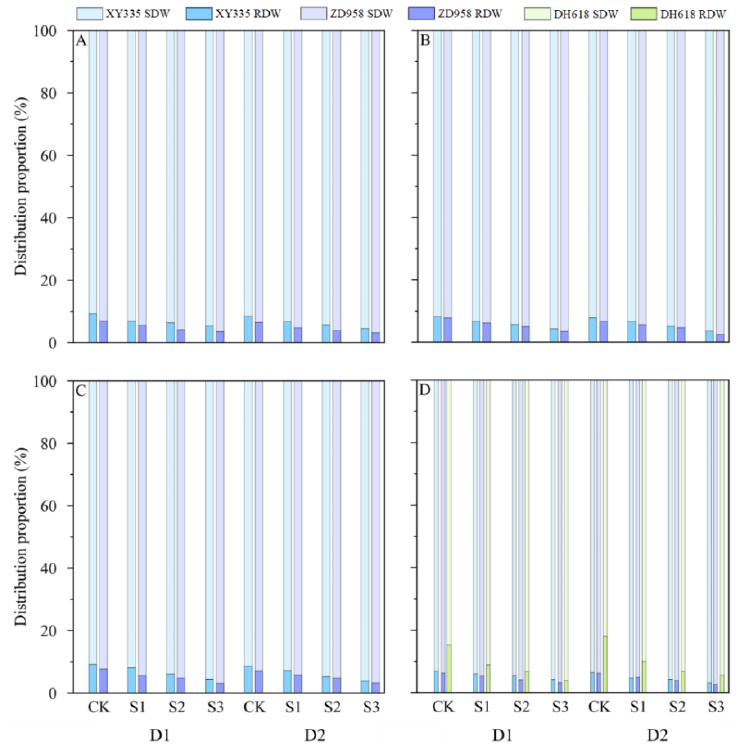
Figure 6. Distribution ratio of aboveground and underground biomass under different shading levels and planting densities. ( A ) 2018 Yinchuan; ( B ) 2019 Yinchuan; ( C ) 2018 Qitai; ( D ) 2019 Qitai.